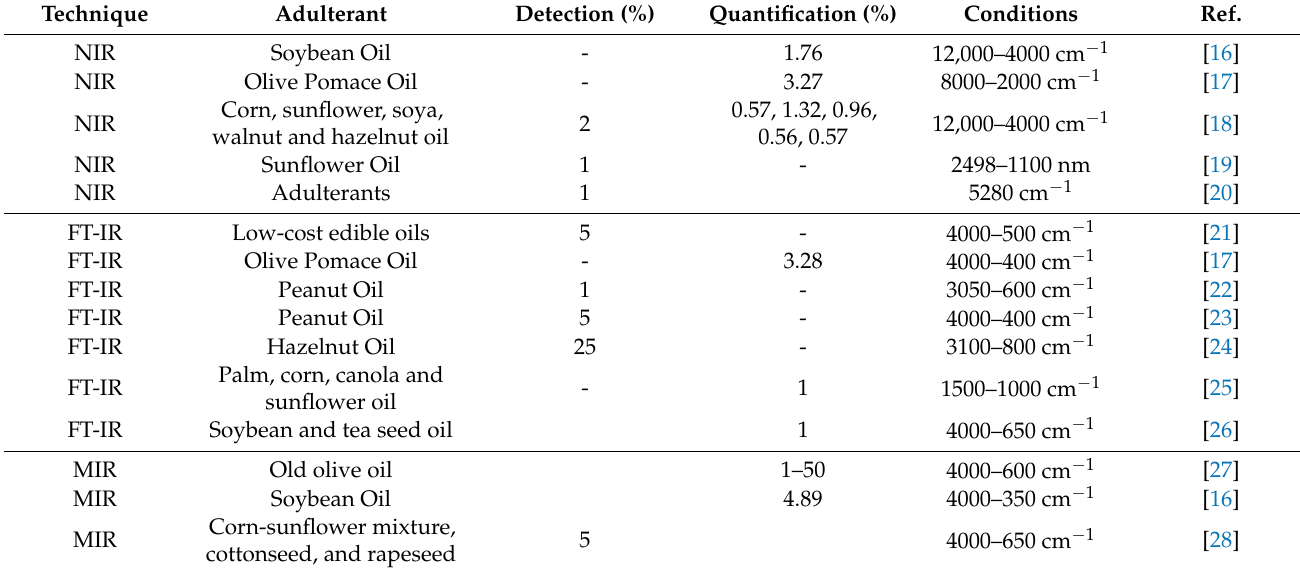
Table 1. Tests carried out with spectrometric techniques to determine and/or quantify adulterations in olive